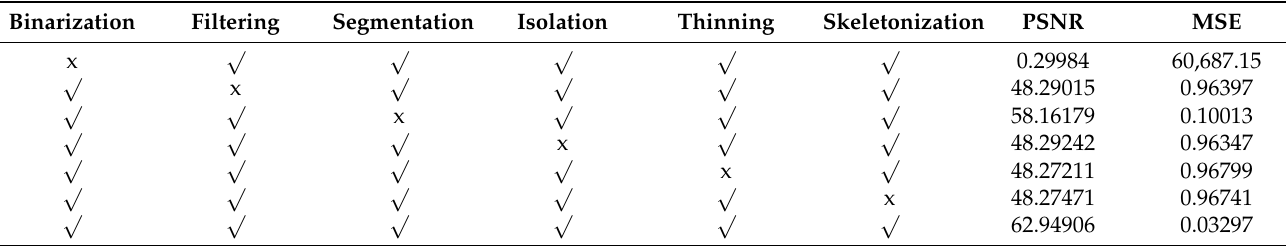
Table 3. Results of preprocessing on the UTSIG database.